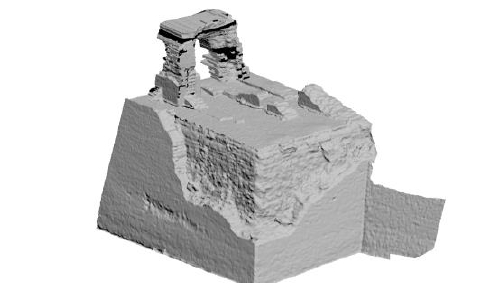
Figure 10. The constructed model fusing two types of DIM points